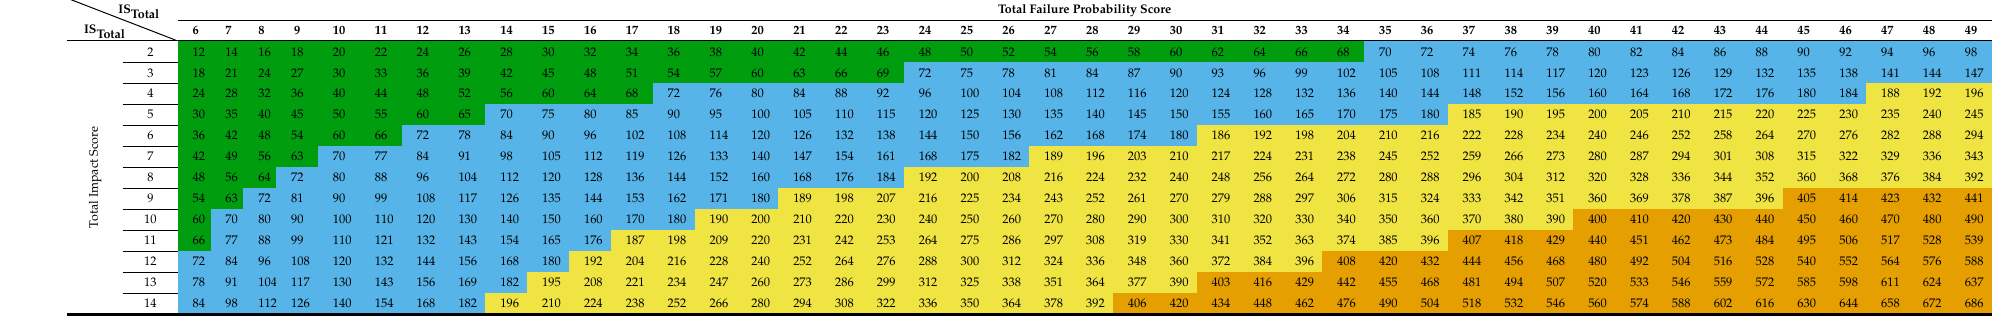
Table 6. Risk matrix—RFS